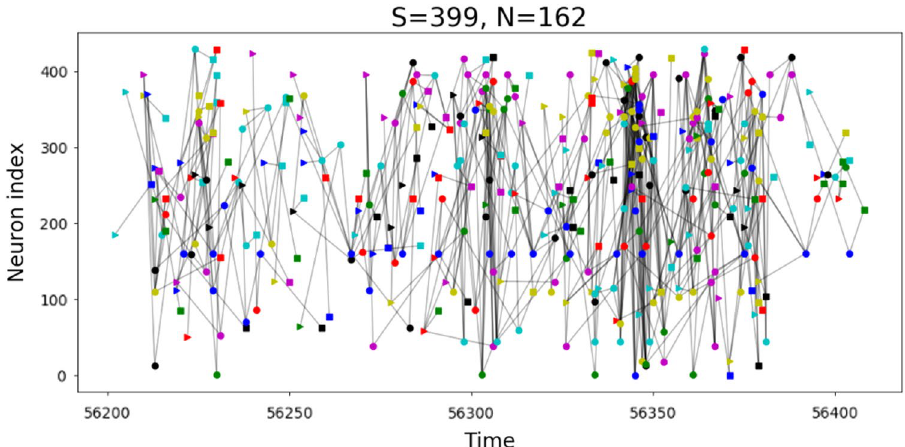
Figure 1. Causal webs. Time trace of a recurrent avalanche in mouse. For a single large avalanche with size S = 399 and number of neurons N = 162, the causal web of firing activity. Individual neurons are labeled by an arbitrary neuron index (y-axis, not all neurons participate in this avalanche), which fire at particular times (x-axis, in ms since start of recording). The causal web is a directed graph whose nodes are indexed by the pair (neuron, time). Nodes with no incoming edges are indicated by right-pointing triangles, nodes with no outgoing edges are indicated by squares, and nodes with both incoming and outgoing edges are indicated by circles. Patterns of recurrent neural activity are seen as particular neurons fire repeatedly during the avalanche, leading to horizontal trace of like-colored